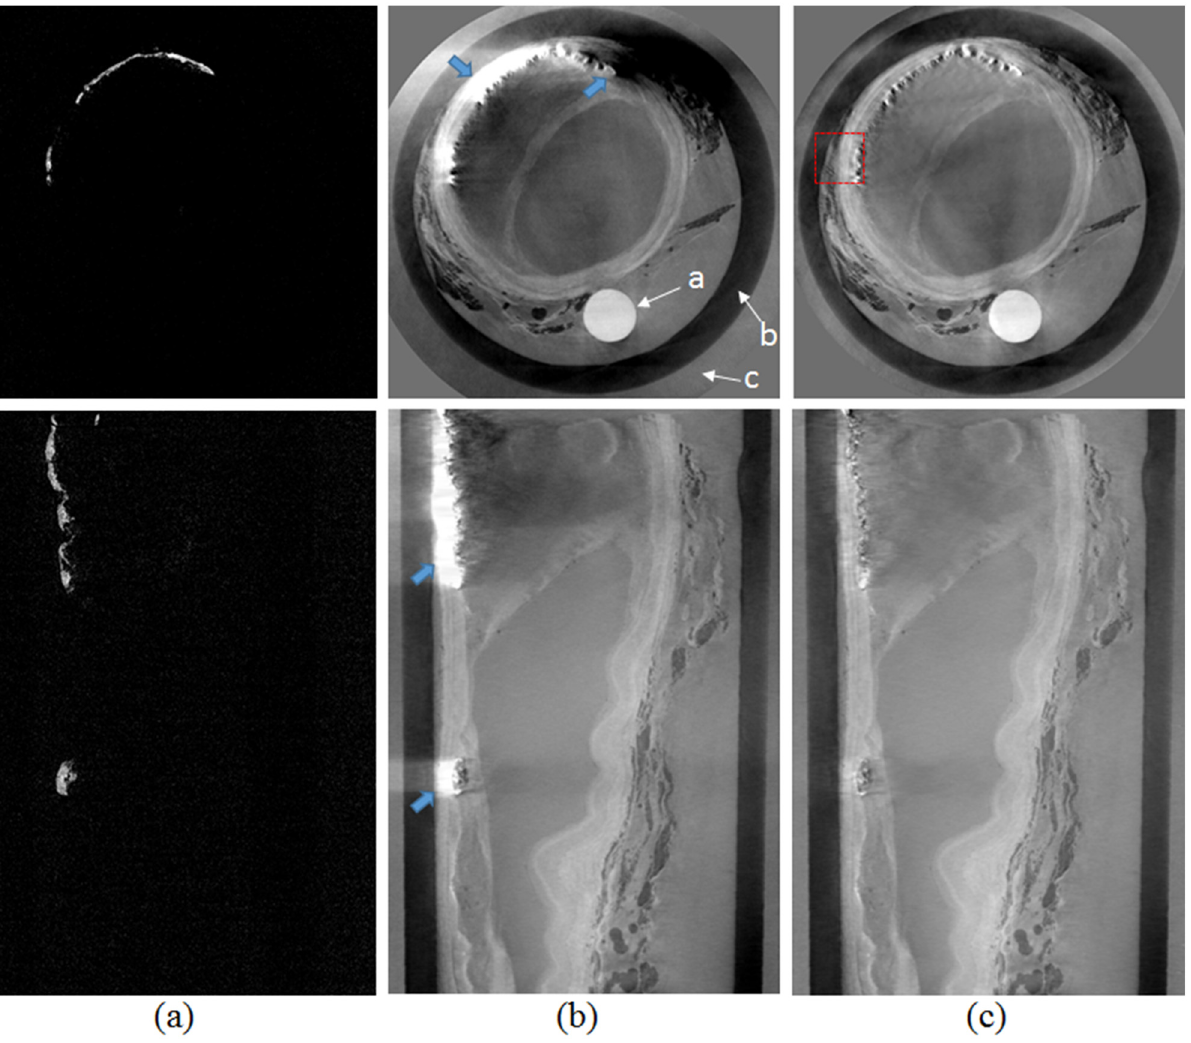
Fig 7. Iliac artery specimen in cross-sectional (top) and longitudinal (bottom) cut planes. Absorption-contrast images (a), phase-contrast images with calcification artefact (b), and phase-contrast image using the proposed artefact removal algorithm (c) are